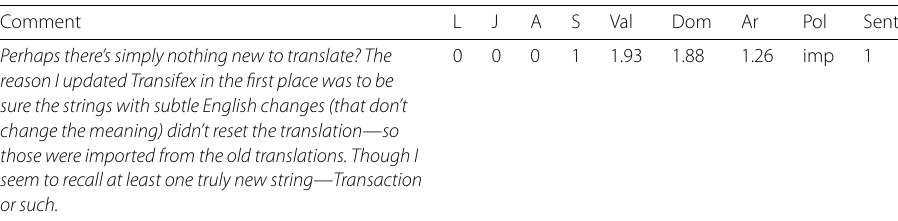
Table 1 Example of comments and the corresponding values of affect (love (L), joy (J), anger (A), sadness (S)), VAD (valence (Val), dominance (Dom), arousal (Ar)), politeness and sentiment (Pol and Sent